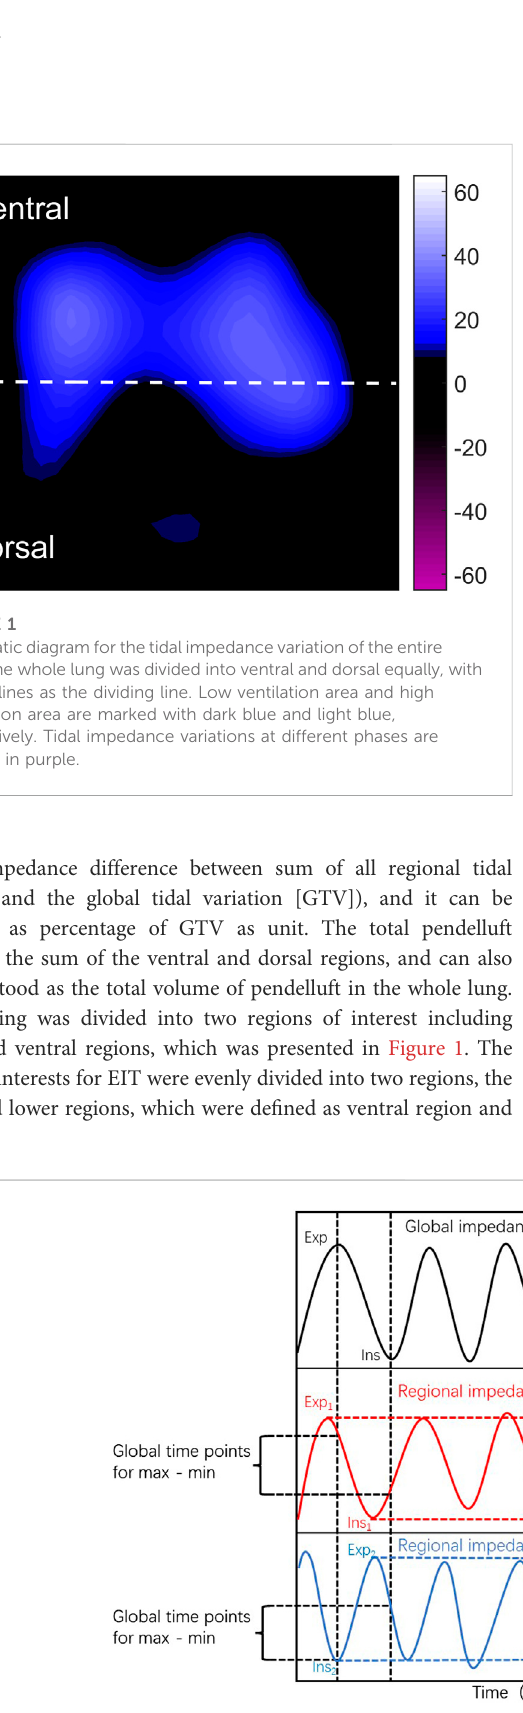
FIGURE 2 Pendelluft amplitude estimation based on electrical impedance tomography.The global impedance – time curve is presented in the upper row. The middle and bottom rows present the impedance – time curve from two representative pixels. The timepoints of nadir impedance (Ins) and peak impedance (Exp) are recognized as the starting and ending points of inspiration for global and regional pixels. The global tidal variation was de fi ned as impedance difference between global Ins and Exp. The regional tidal variation was de fi ned as impedance difference between regional Ins and Exp. The pendelluft volume was calculated as the difference between regional and global tidal